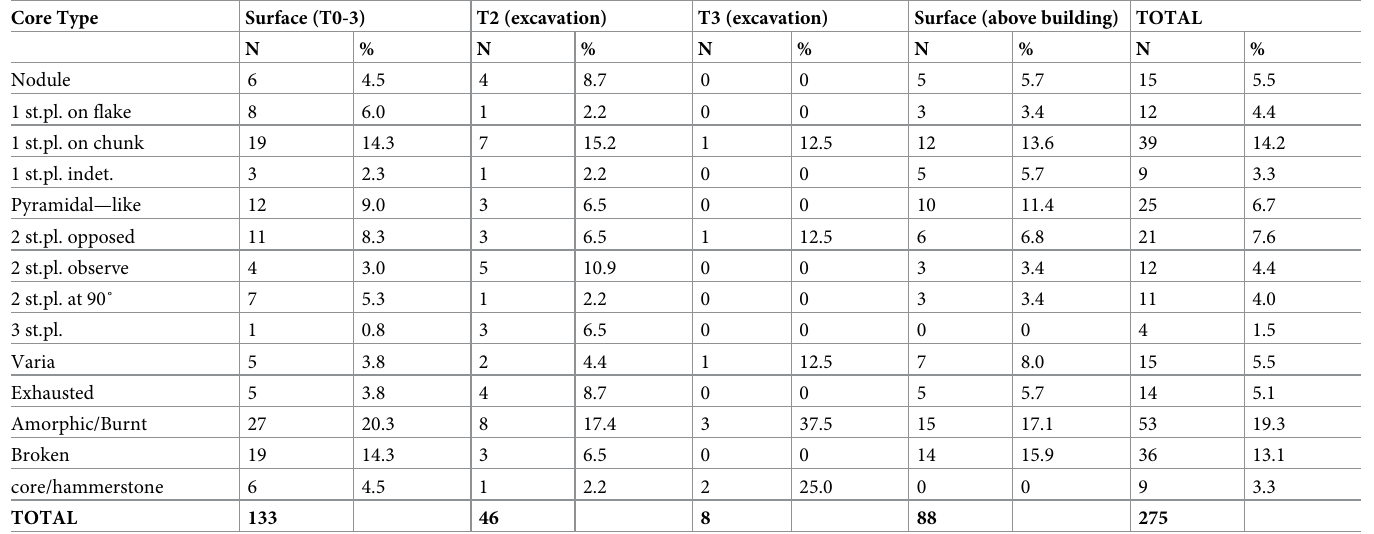
Table 5. Core types–Kaizer Hill Terraces.